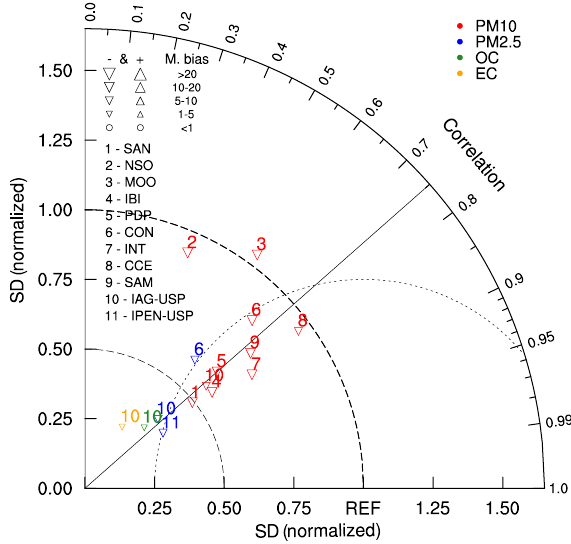
Figure 10. Taylor diagram (Taylor, 2001) showing the individual correlation coefficients, mean biases, and normalized standard de- viations for the PM 10 , PM 2 . 5 , OC, and EC